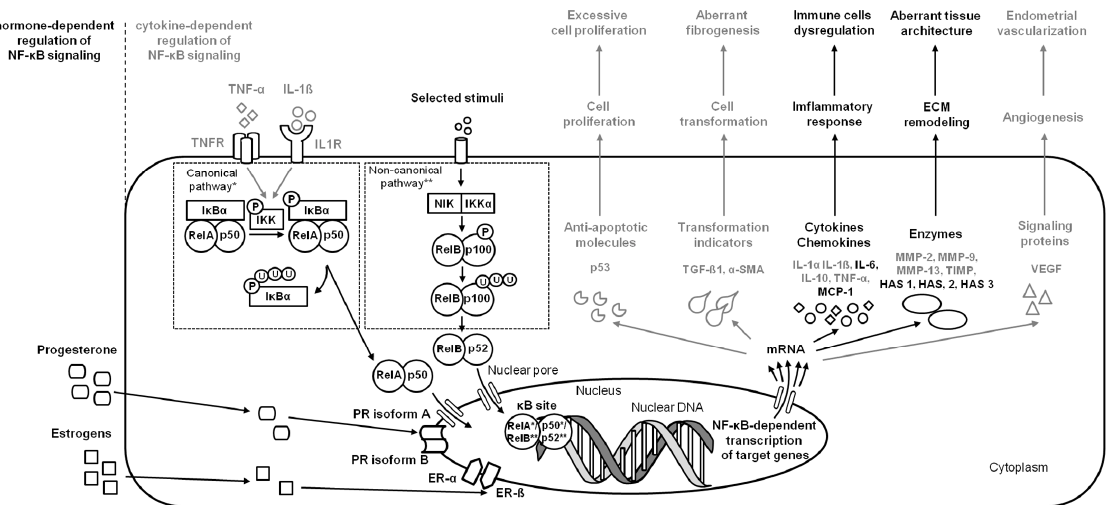
Figure 3. A simplified schema of the NF- κ B signaling pathway in the endometrium in the case of endometrosis. Studied pathways are marked in black. Pathways requiring further research are marked in grey. Both canonical pathway * and noncanonical pathway ** are considered.